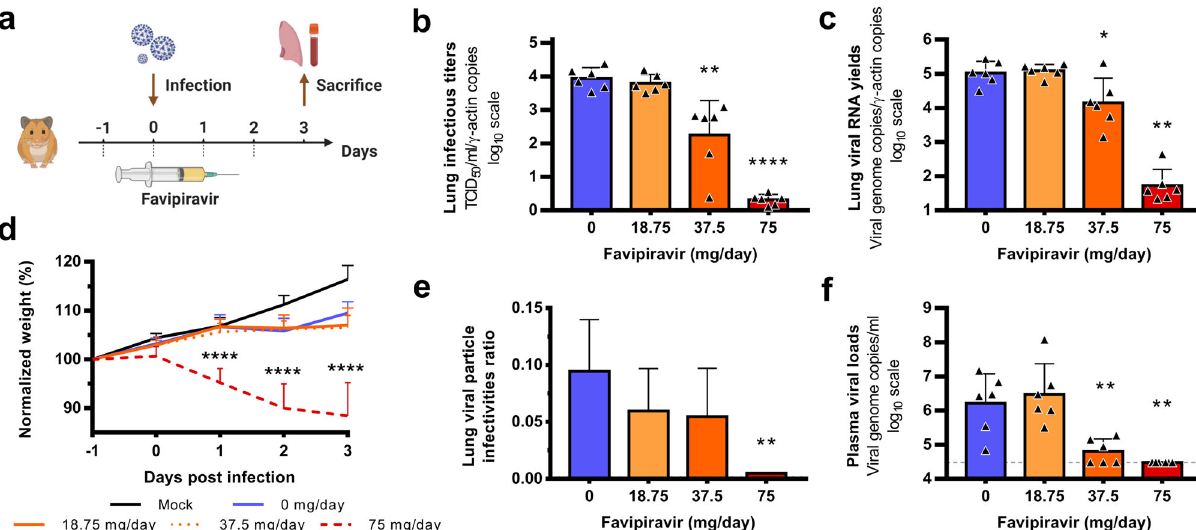
Fig. 3 Virological results with preventive favipiravir therapy. a Experimental timeline. Groups of 6 hamsters were intranasally infected with 10 4 TCID 50 of virus. b Viral replication in lungs based on infectious titers (measured using a TCID 50 assay) expressed in TCID 50 /copy of ɣ -actine gene ( n = 6 animals/ group). c Viral replication in lungs based on viral RNA yields (measured using an RT-qPCR assay) expressed viral genome copies/copy of ɣ -actine gene ( n = 6 animals/group). d Clinical course of the disease ( n = 6 animals/group). Normalized weight at da y n was calculated as follows: % of initial weight of the animal at day n . e Relative lung virus infectivities were calculated as follows: ratio of lung infectious titer over viral RNA yields ( n = 6 animals/group). f Plasma viral loads (measured using an RT-qPCR assay) are expressed in viral genome copies/mL of plasma (the dotted line indicates the detection threshold of the assay) ( n = 6 animals/group). Data represent mean ± SD (details in Supplementary Data 2). Statistical analysis were performed using Shapiro – Wilk normality test, Student t -test, Mann – Whitney test, One-sample t -test and two-way ANOVA with Post-hoc Dunnett ’ s multiple comparisons test (details in Supplementary Data 3 and 4). ****, ** and * symbols indicate that the average value for the group is signi fi cantly different from that of the untreated group with a p -value < 0.0001, ranging between 0.001 – 0.01 and 0.01 – 0.05, respectively. Source data are provided as a Source data fi